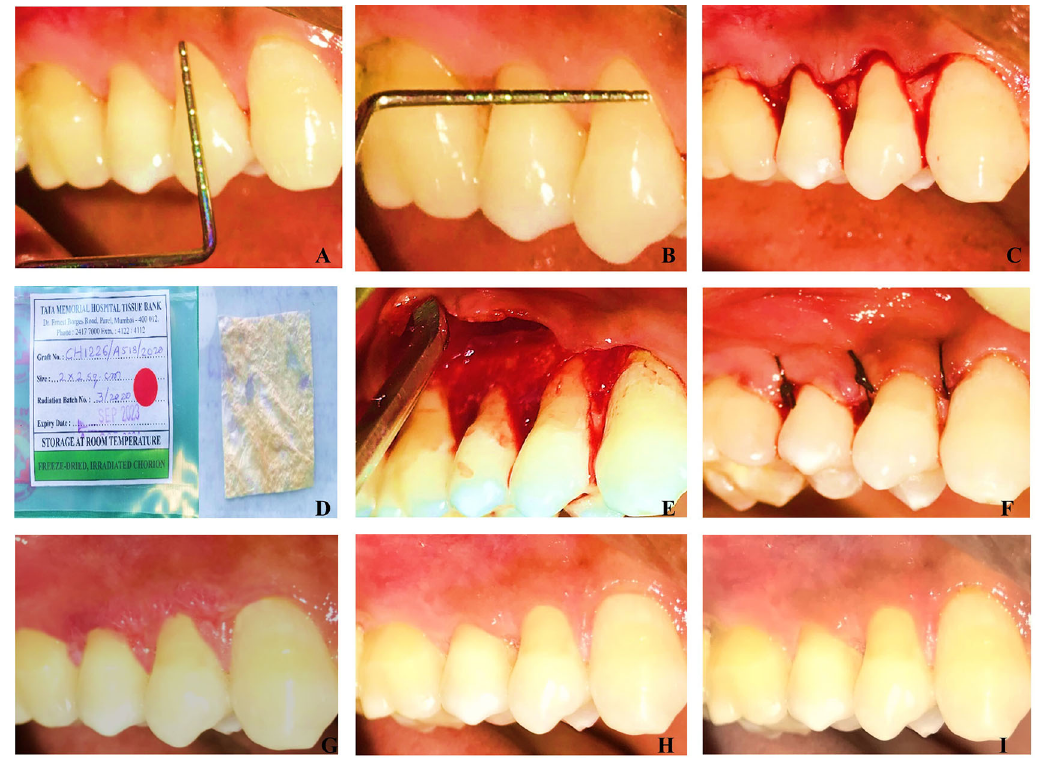
Figure 1. A&B: Pre-operative recession depth and width measurement of the CAF+CM Group. C: Horizontal IncisionsweremadeandSplit-full-split thicknessflapreflected.D:Freezedriedirradiatedchorionmembrane from Tata Memorial Hospital Tissue Bank. E: Placement of Chorion membrane at the defect site. F: Indepen- dent Sling sutures placed. G: 15 days post-operative view of the site. H: Three months post-operative view of the site treated by CAF+CM. I: Six months post-operative view of the site treated by